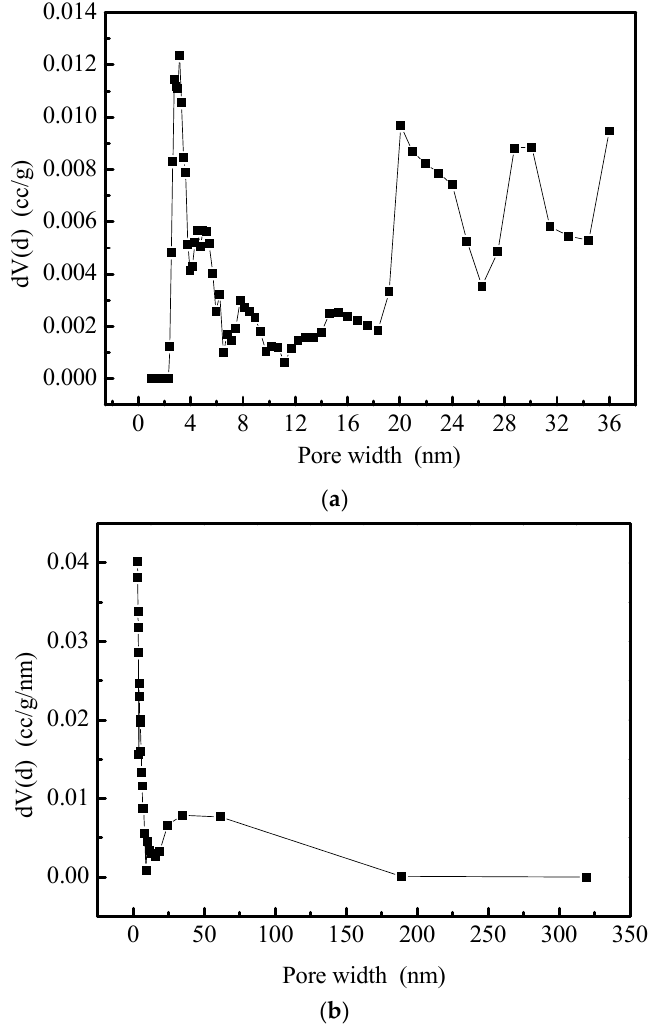
Figure 6. Distribution of the pore width of the solid amine. ( a ) Pore size distribution calculated using the DFT method. ( b ) Pore size distribution calculated using the BJH